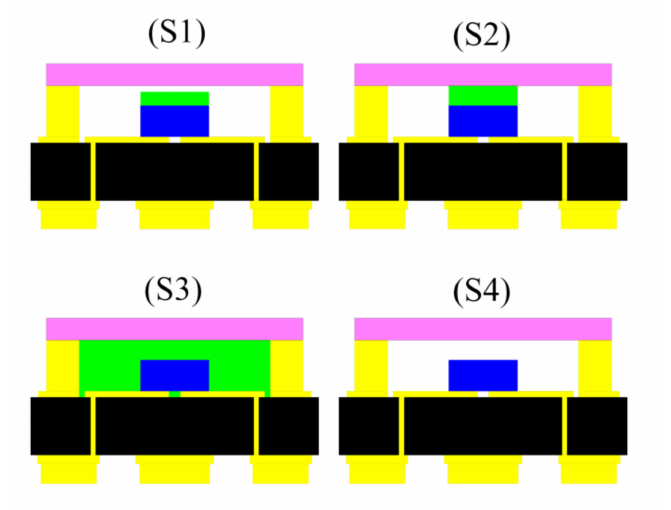
Figure 2. Structural diagrams of the packaging structures (samples S1–S4). The yellow part is the DPC film with an Au coating over the surface; the blue part is the LED chip; the green part is the encapsulated silicone; the pink part is the quartz glass; and the black part is the AlN ceramic material.